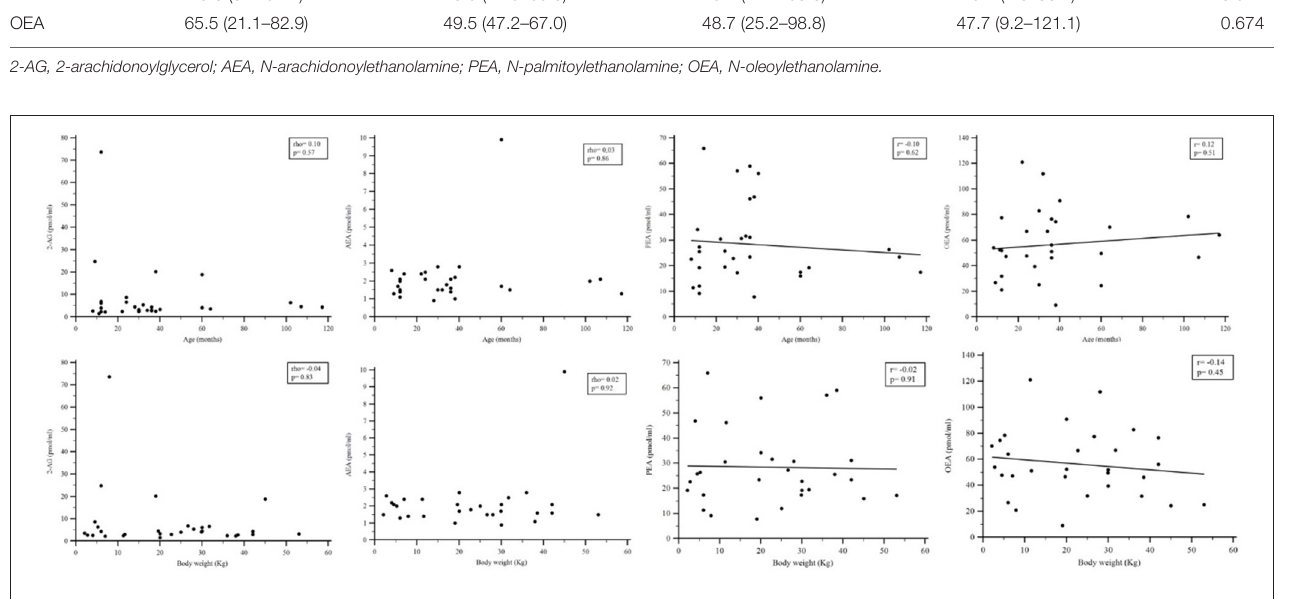
FIGURE 1 | Rank correlation analysis comparing plasmatic concentrations of endocannabinoids and age or bodyweight in healthy dogs. 2-AG, 2-arachidonoylglycerol; AEA, N-arachidonoylethanolamine; PEA, N-palmitoylethanolamine; OEA,